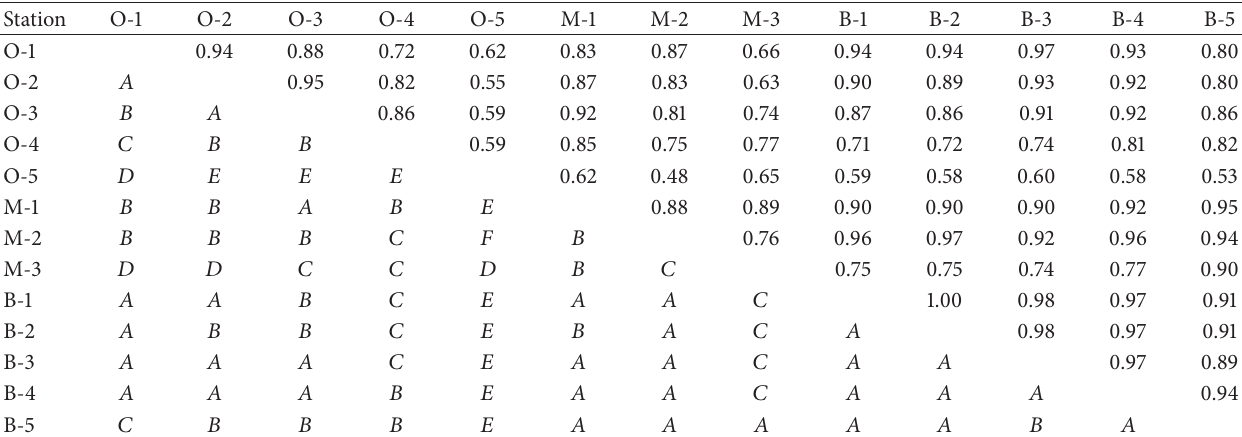
Table 4: Correlation of O concentration measured by different air quality 3